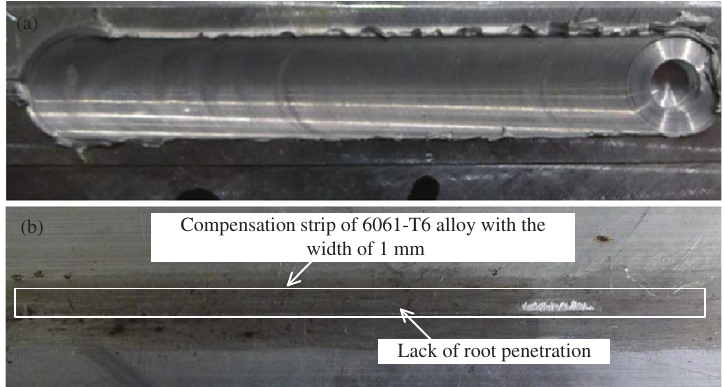
Figure 3: VCFSW joint of 6061-T6 aluminum alloy as compensation strip: (a) front and